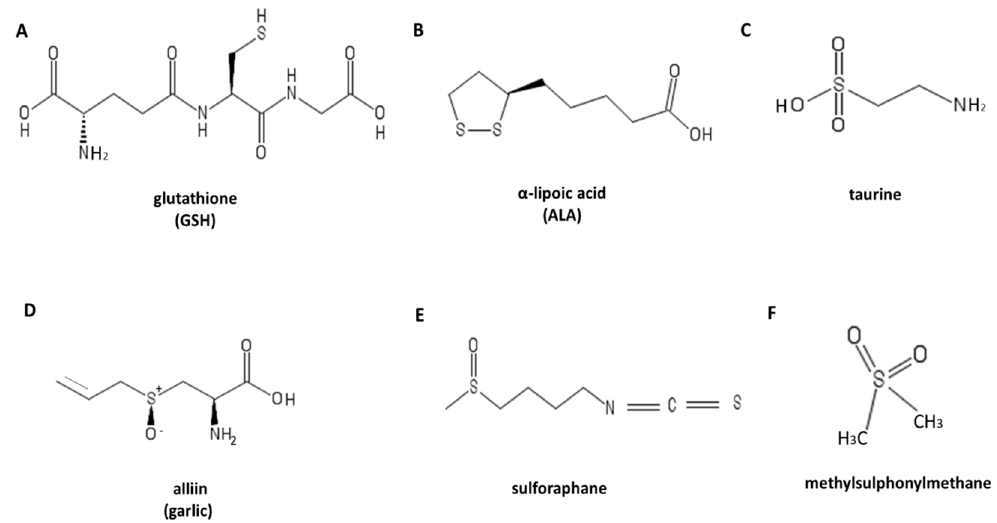
Figure 3. Chemical structures of sulfur-containing antioxidants with therapeutic potential against oxidative stress. Table 1. Therapeutic efficacy of sulfur-containing compounds in sports activity.